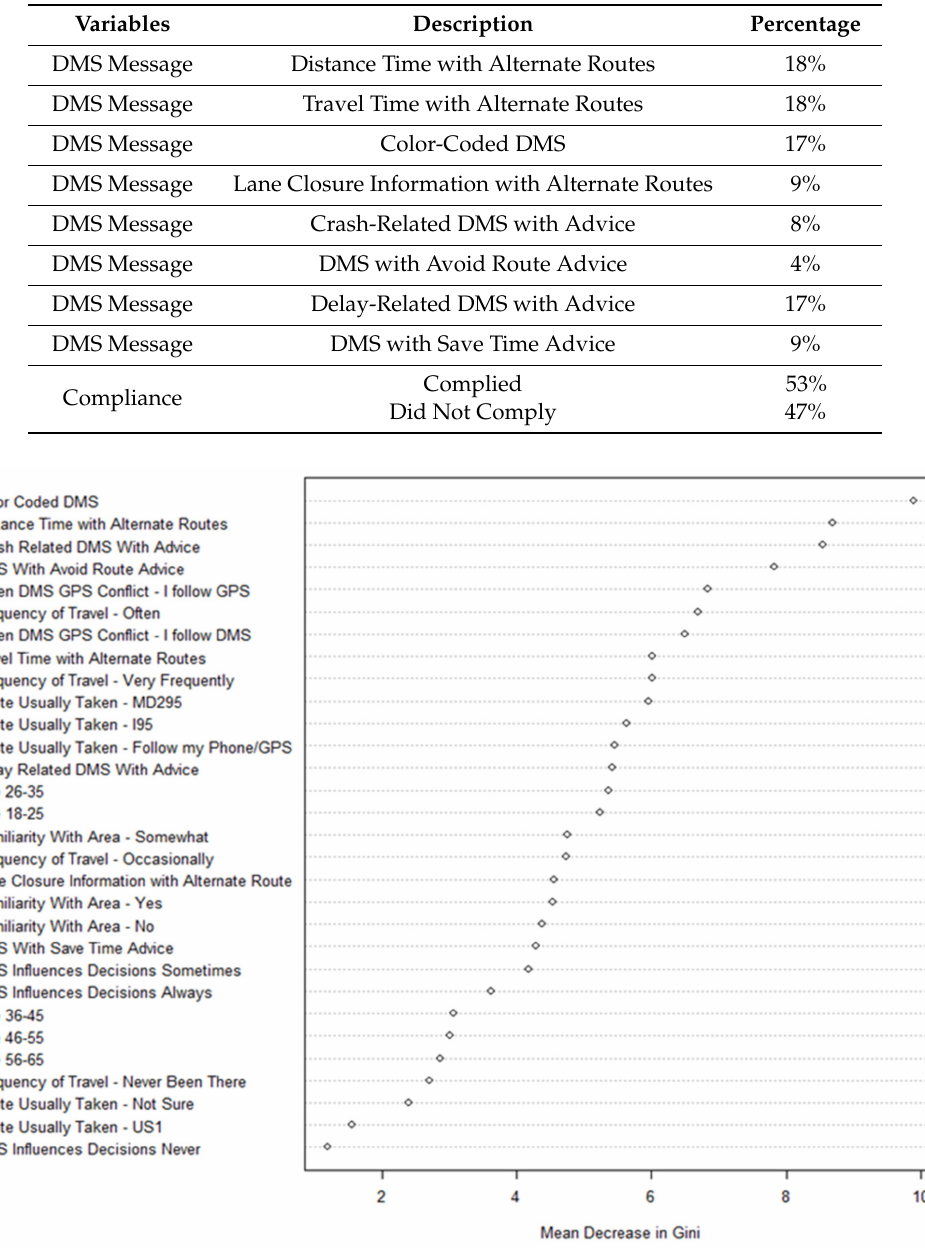
Table 6. Descriptive statistics of compliance dataset.